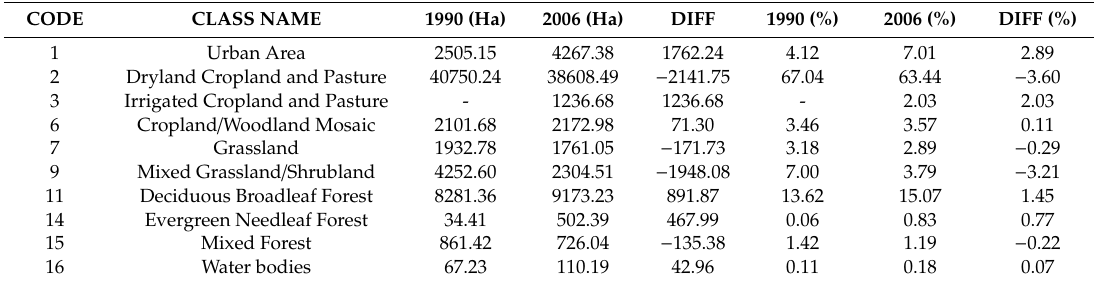
Table 1. LCLU classes obtained for 1990 and